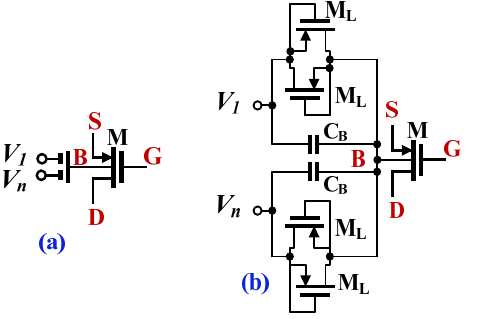
Figure 3. The symbol of bulk-driven MI-MOST ( a ) and the CMOS realization ( b ).